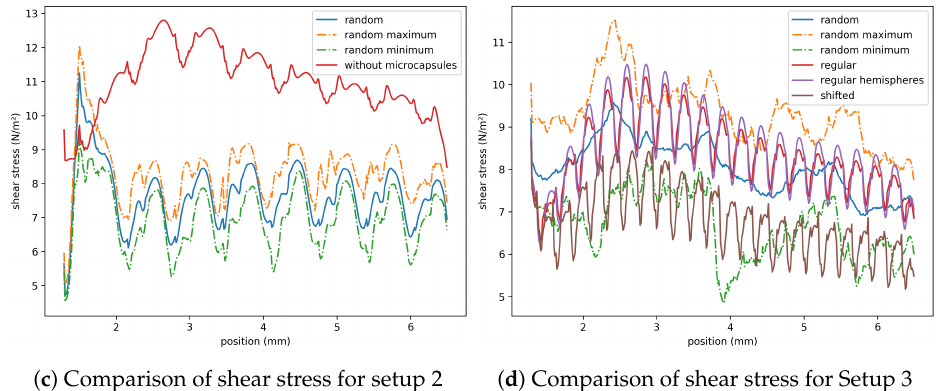
( c ) Comparison of shear stress for setup 2 ( d ) Comparison of shear stress for Setup 3 Figure 10. Distribution of the average shear stress at the top surface of the